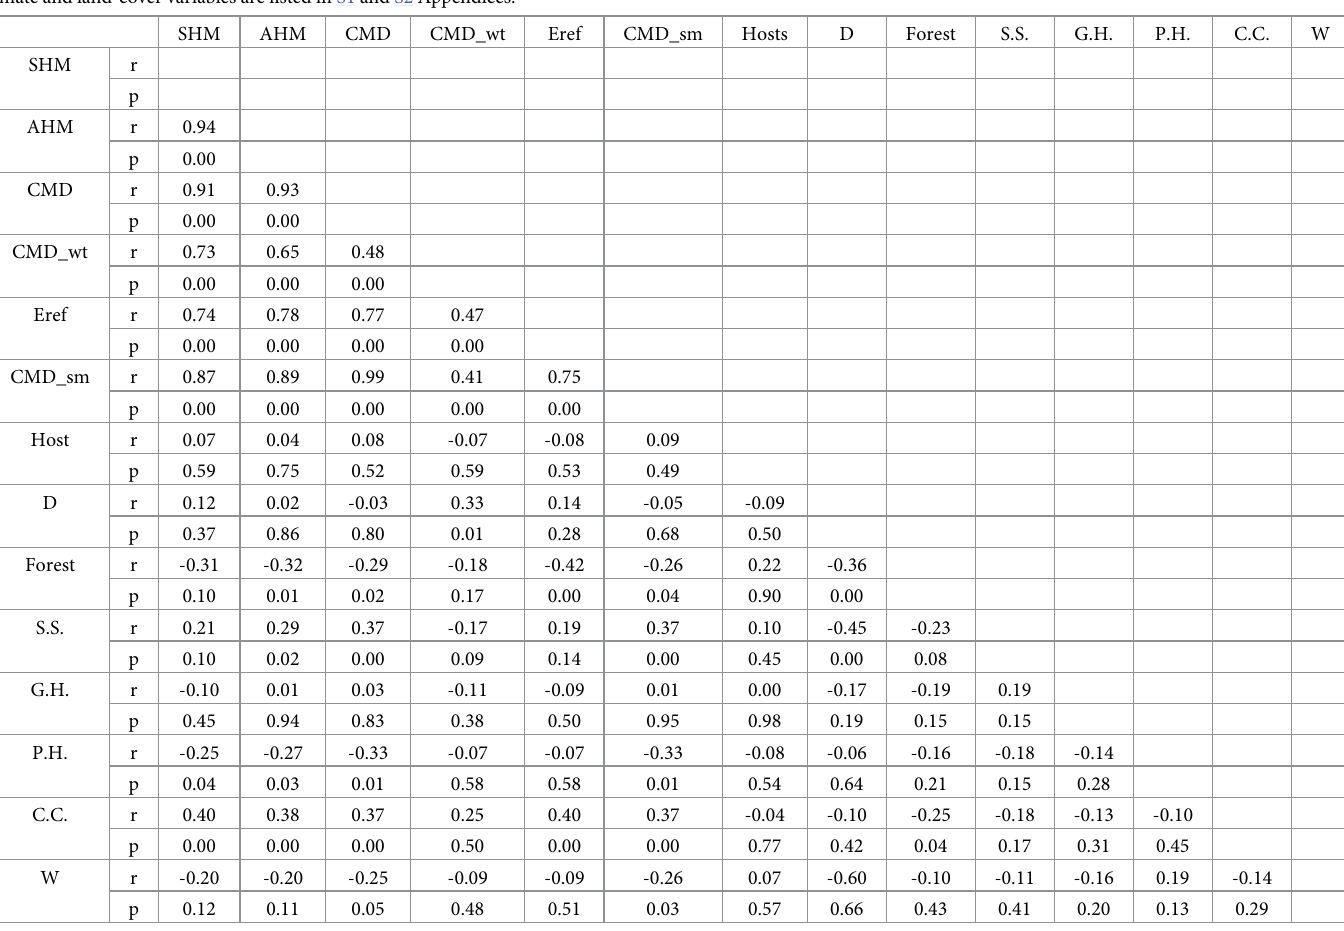
Table 2. Pearson’s correlation (r) and p values for R . indifferens . Results show that most of the climate variables were correlated with each other. SHM = summer heat- moisture index, AHM = annual heat-moisture index, CMD = Hargreaves climatic moisture deficit, CMD_wt = winter Hargreaves climatic moisture deficit, CMD_sm = summer Hargreaves climatic moisture deficit, Eref = Hargreaves reference evaporation, Host = host plant abundance, Forest = evergreen, deciduous and mixed forests, D = developed, S.S. = shrub-scrub, G.H. = grassland herbaceous, P.H. = pasture-hay, C.C. = cultivated crops, and W = wetland. Complete descriptions of cli- mate and land-cover variables are listed in S1 and S2 Appendices.